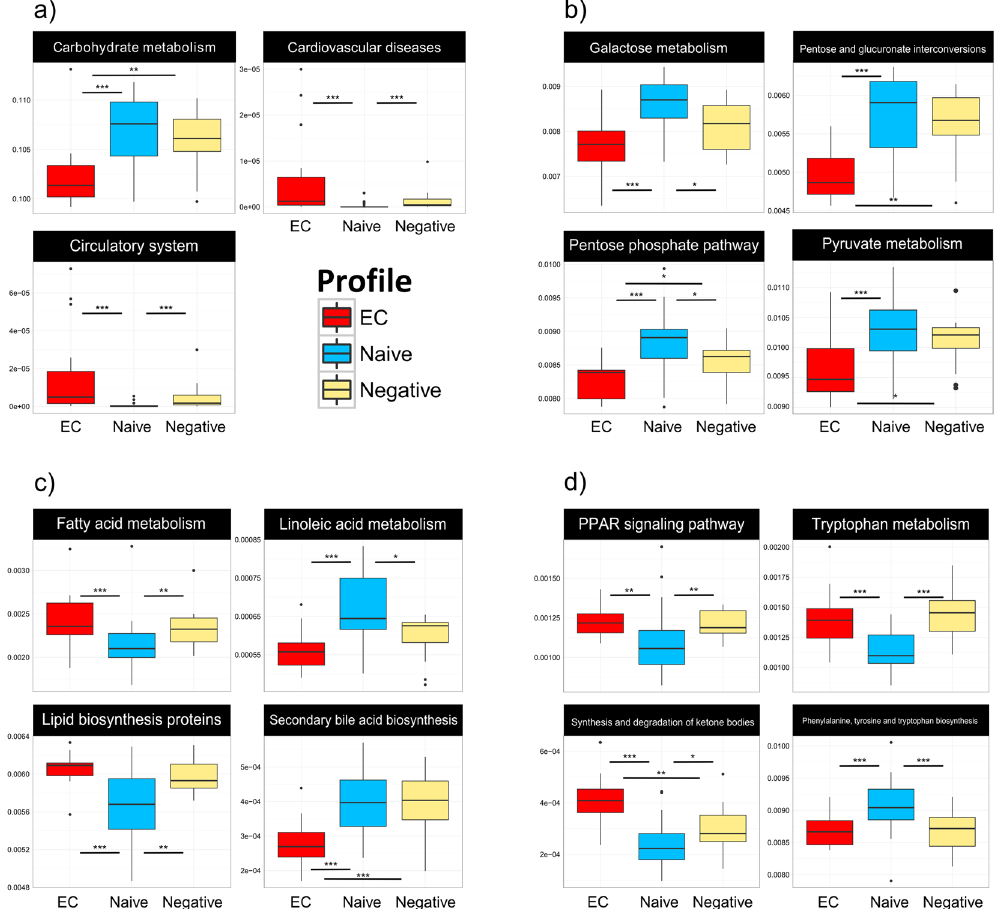
Figure 4. Inferred functional content of gut microbiota. The metagenomic functional content of gut microbiota was predicted by inferred PICRUSt analysis. Abundance of pathways involved in carbohydrate metabolism, cardiovascular diseases and circulatory system at KEGG level II ( a ), or level III ( b – d ). Pathways involved in carbohydrate metabolism, galactose metabolism, pentose and glucoranate interconversions, pentose-phosphate pathway and pyrovate metabolism ( b ). Pathways related to metabolism of lipids and fatty acids and biosynthesis of secondary bile acids ( c ). Bacterial tryptophan metabolism, PPAR signaling, phenylalanine, tyrosine and tryptophan biosynthesis and synthesis and degradation of ketone bodies pathways ( d ). Kruskal – Wallis rank- based test was applied, and Benjamini – Hochberg method was used to correct for multiple testing. Adjusted p-value < 0.01 was considered significant for Kruskal-Wallis. Dunn’s post-hoc pairwaise analyses: * p < 0.05, ** p < 0.01, *** p < 0.001. Box plots represent median (black horizontal line), 25th and 75th quartiles (edge of boxes), upper and lower extremes (whiskers). Outliers are represented by a single data